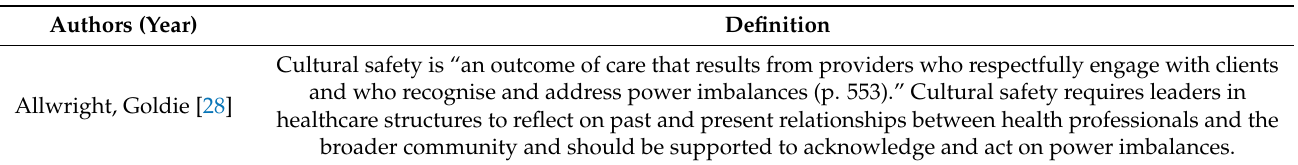
Table 1. Definition of cultural safety from international